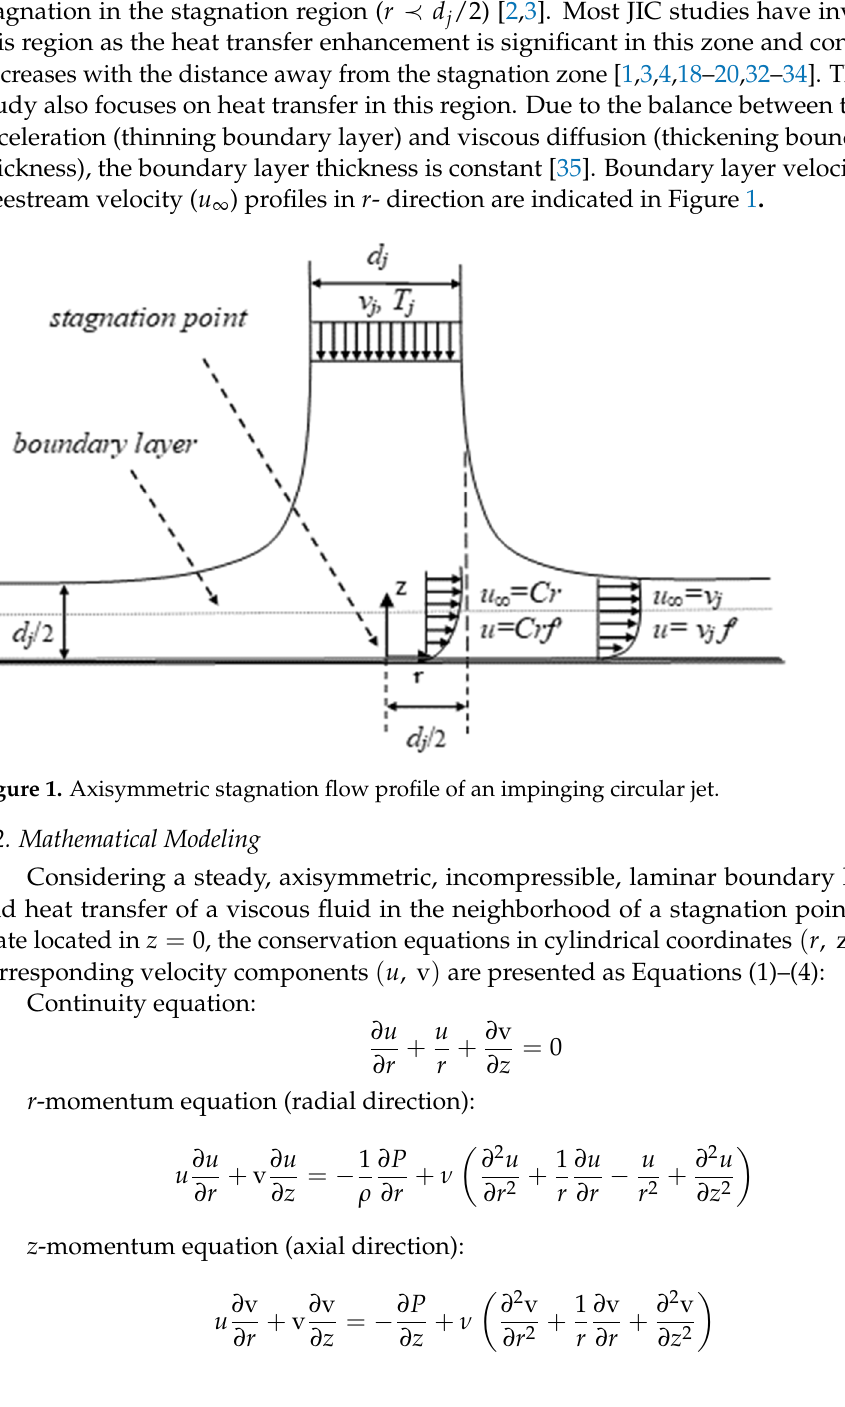
r -momentum equation (radial direction):